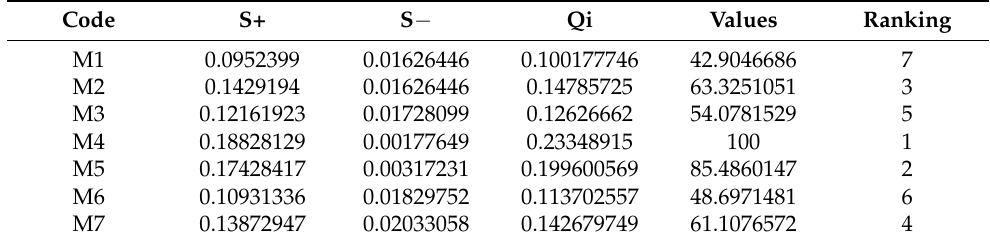
Table 24. Positive and negative normalized weights.